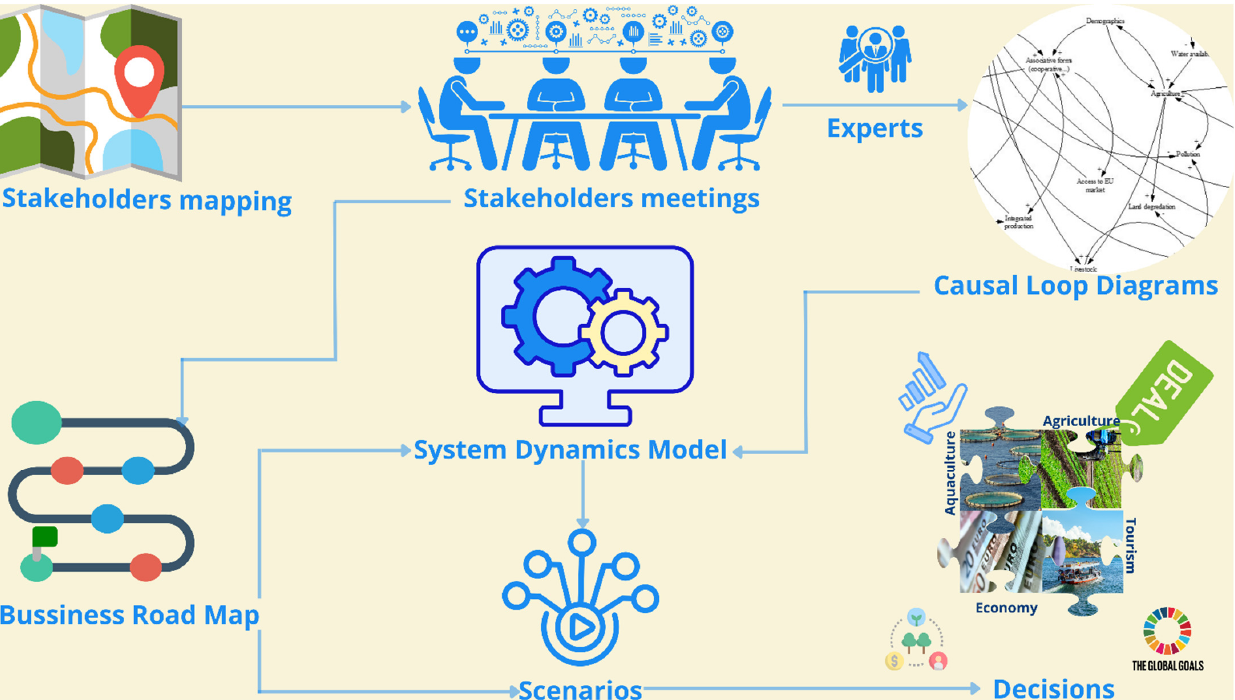
Figure 2. COASTAL methodology for decision makers on the Danube Delta’s sustainable development.